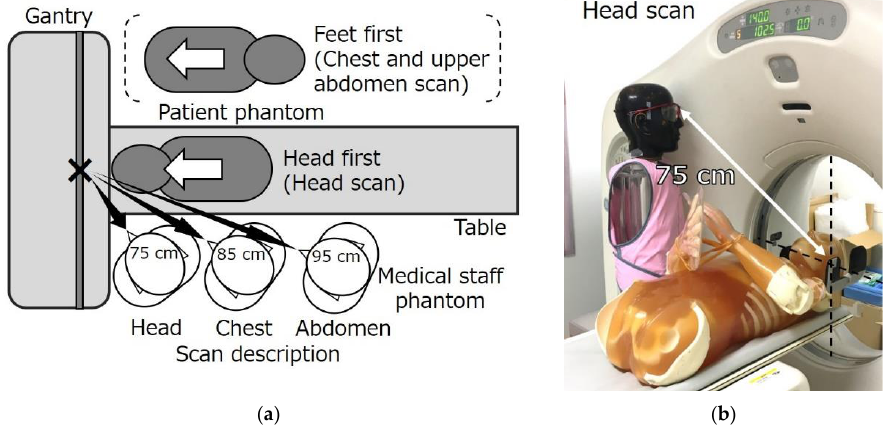
Figure 2. Layout in dose measurement. ( a ) a top view and ( b ) an example; the layout of head scan. Table 1. Scan parameter and dose information obtained from the CT scanner console. H p (3) of the medical staff per DLP in each scan was also determined. The value of H p (3) in each scan was normalised to that in the 75 cm position based on the inverse square law. The normalised H p (3) was divided by